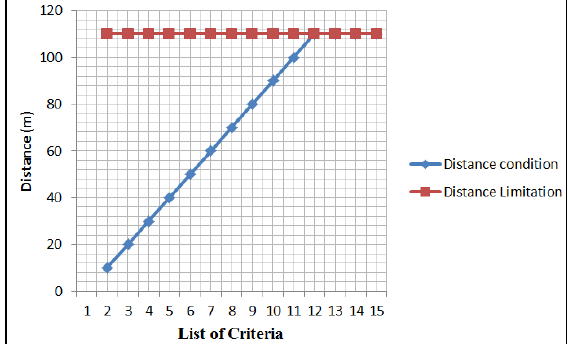
Figure 2.Flow in finding secondary